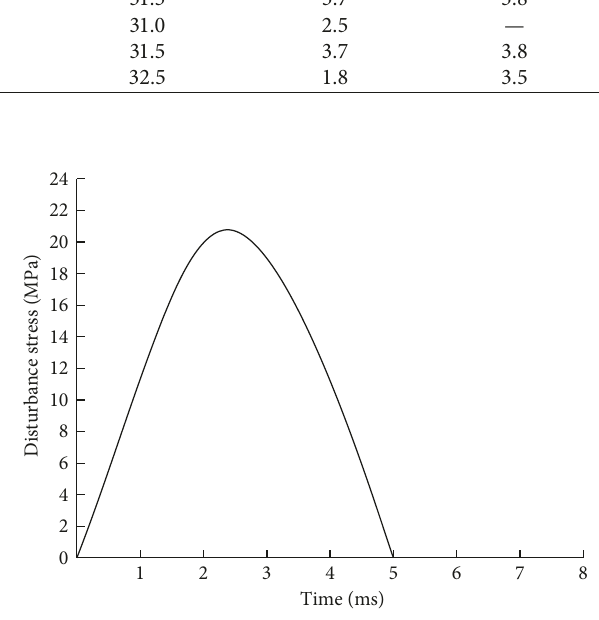
Figure 4: Time-history curve of the blasting disturbance stress